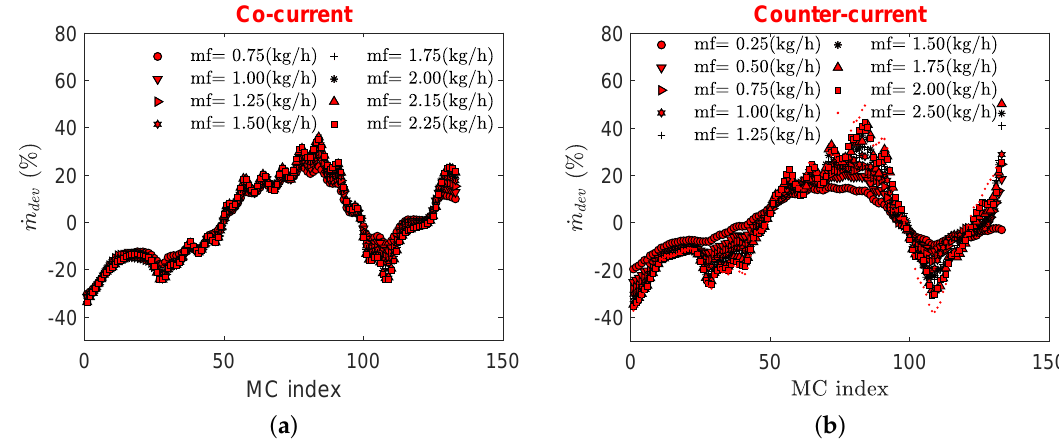
Figure 9. Flow maldistribution in MCs for cocurrent flow ( a ), and counterflow ( b ).